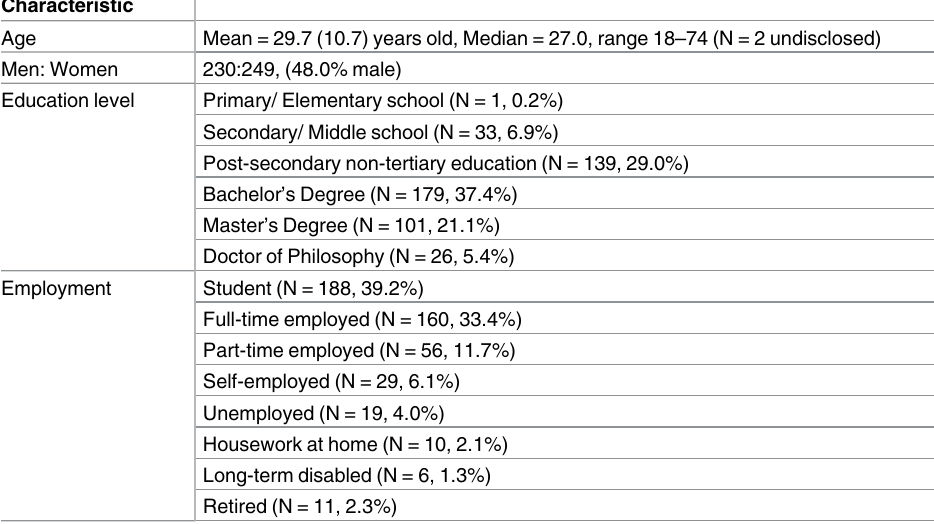
Table 2. Participant